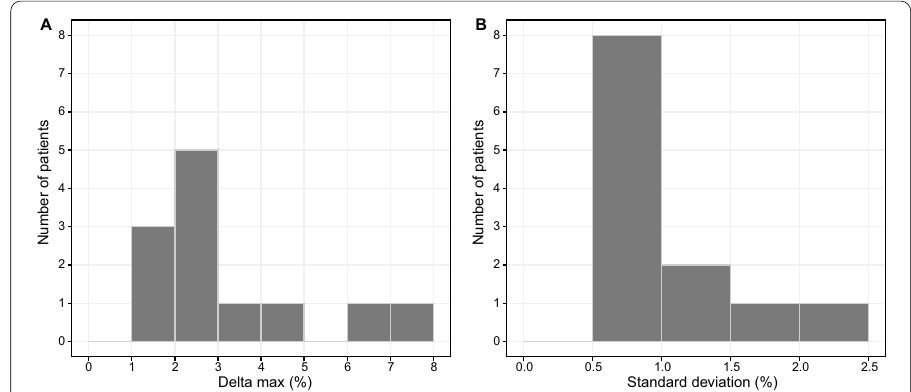
Fig. 4 Histograms of ( a ) difference between highest and lowest measured left renal uptake percentage (LRU%) within a patient (“delta max”) and ( b ) standard deviation of LRU% measurements